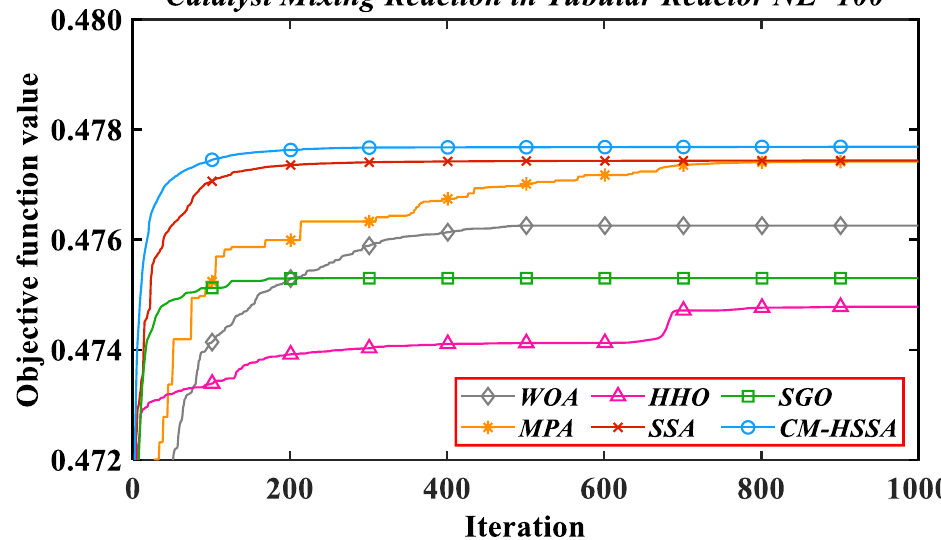
Figure 22. Iterative trajectories of six algorithms for Problem 2. Table 6. Comparison of optimization results for Problem 2.